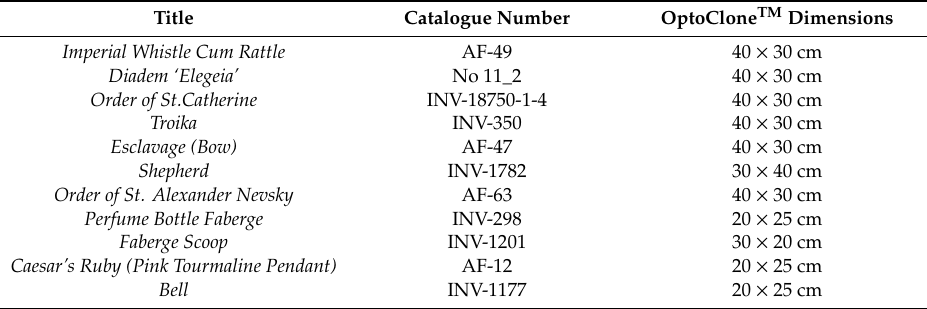
Table 4. Gokhran Diamond Fund objects recorded as OtptoClones TM .